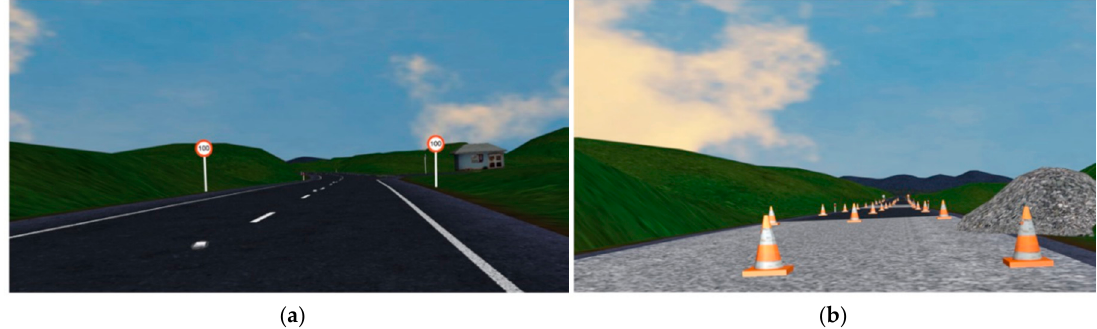
Figure 6. View from the driver’s perspective in the control ( a ) and roadworks ( b ) driving scenarios.